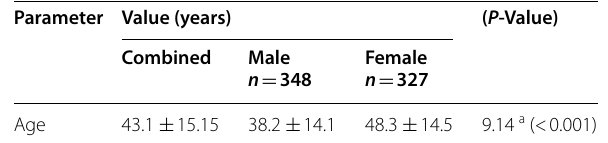
Comparison between prostheses in the Philippine and Asian markets